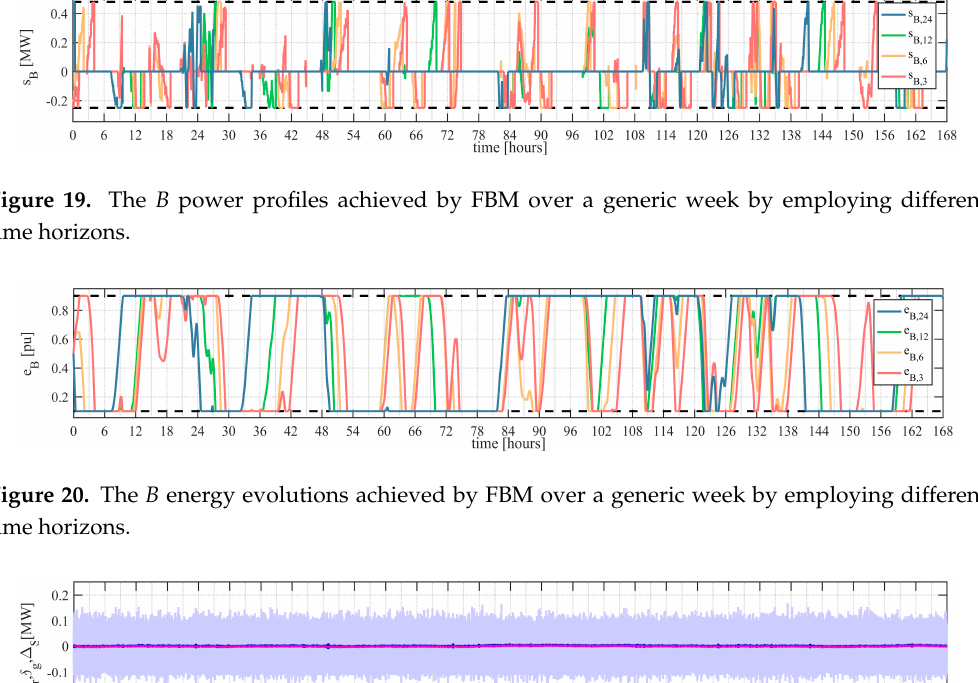
Figure 18. Residual and grid power profiles achieved by FBM over a generic week by employing different time horizons.